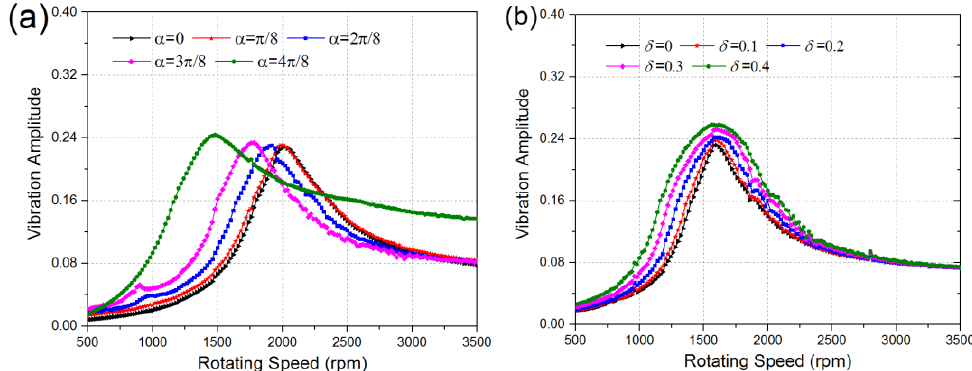
Figure 6. Amplitude–speed diagram along with the growth of crack angle and initial bending. ( a ) crack angle, ( b ) initial bending as α = π/6.